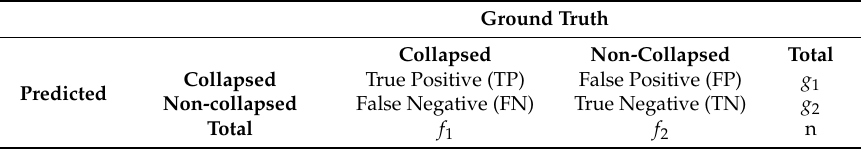
Table 2. Confusion